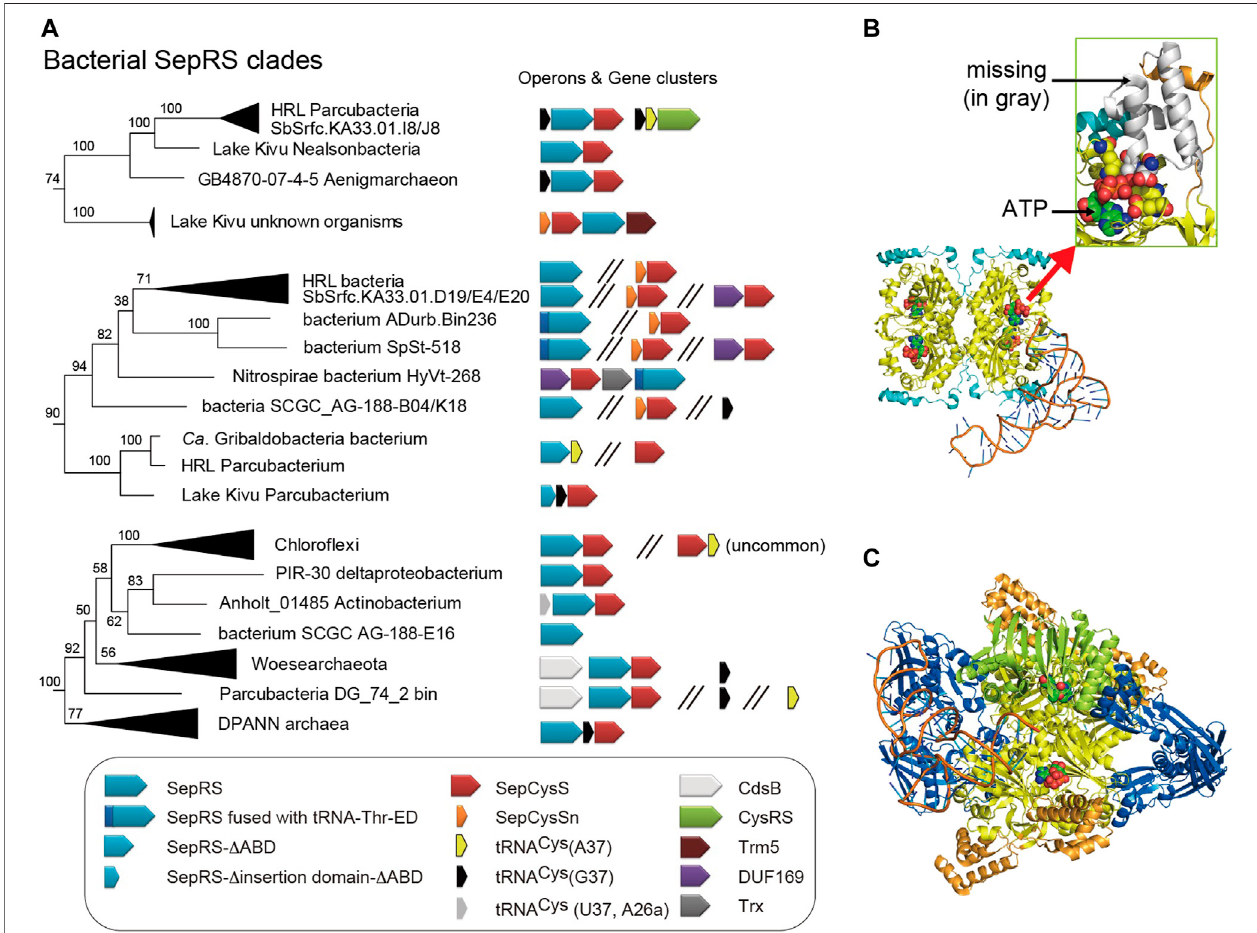
FIGURE5| DiversityofbacterialSepRSspecies. (A) TheterminalbranchesofthethreebacterialSepRScladesfromthephylogenetictreeof Figure4A areshown, together with the operon structures of their SepRS and SepCysS genes. Some of these bacteria may possess tRNA Cys with G37 which is uncommon in bacteria but is recognized by archaeal SepRS via the m 1 G37-recognizing motif. A few Parcubacteria strains may possess a SepRS lacking the anticodon binding domain (ABD). One SepRS variant further lacks most part of the insertion domain. Three SepRS variants were N-terminally fused via a 20-amino-acid linker with a “ tRNA-Thr-ED ” homolog which corresponds tothe serine editingdomain ofarchaeal ThrRS. Hypothetical models ofthese exceptional SepRS (B,C) follow the same color scheme asin Figure 3B . A model of bacterial SepRS lacking the insertion and anticodon binding domains in complex with cognate tRNA. The model shows that both tRNA (anticodon, acceptor stem) and ATP recognition (magni fi ed in the green rectangle) may be impaired (C) A model of SepRS fused to the editing domain of ThrRS. The acceptor stem of tRNA can move between the synthetic active site of SepRS and the hydrolytic (editing) site of the editing domain. The tRNA-Thr-ED model (green) is from the crystal structure of the editing domain of M. jannaschii ThrRS with the substrate analog L -Ser3AA (PDB id: 4RRF).